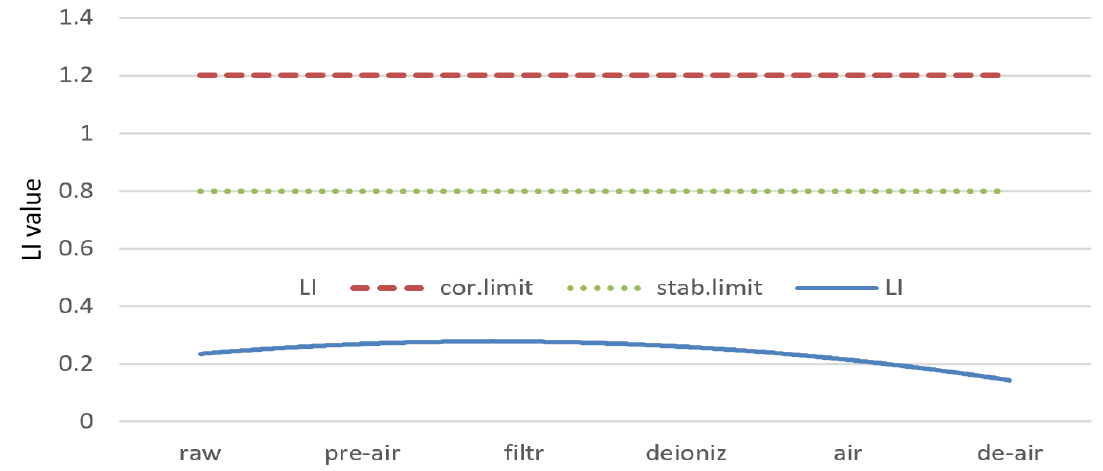
Figure 2. Changes of Larson–Skold Index (LI). Source: Own elaboration.